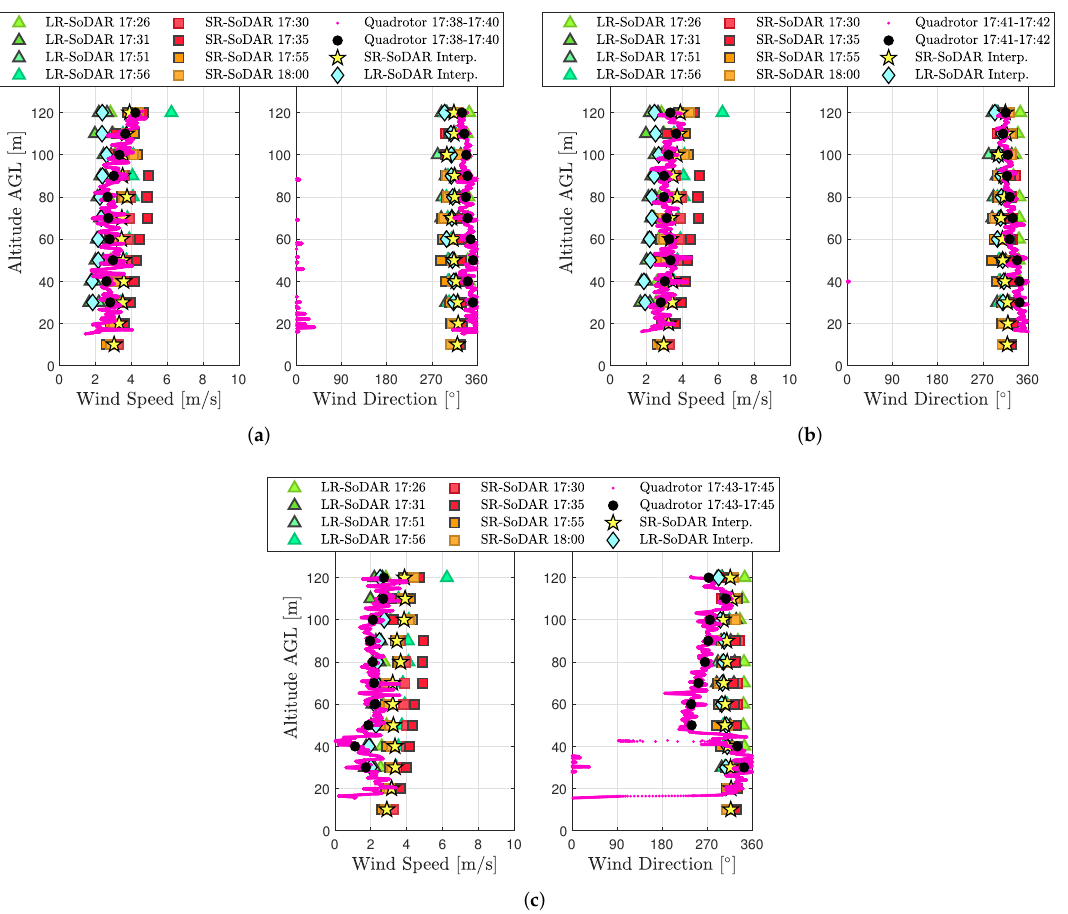
Figure A6. Comparison of wind speed and wind direction profiles from the SoDAR and quadrotor ascending vertically at 1.0 m/s between 10 and 120 m AGL from ( a ) 17:38 to 17:40 EDT, ( b ) 17:41 to 17:42 EDT, and ( c ) 17:43 to 17:45 EDT.